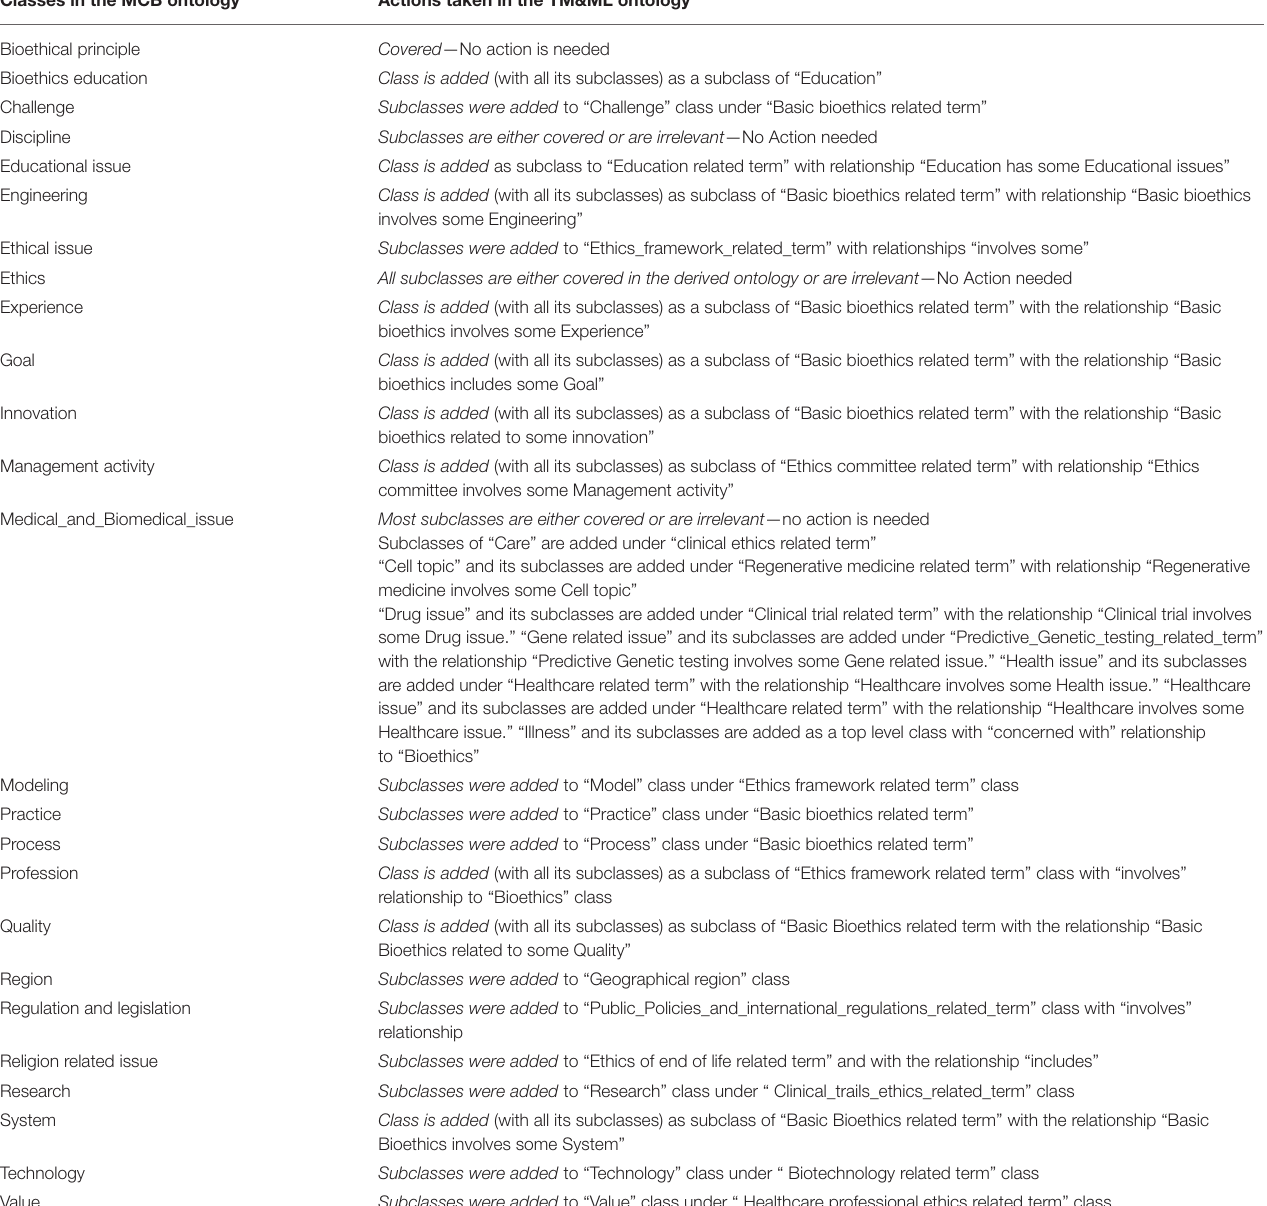
TABLE 1 | The detailed MCB ontology classes that contributed to interfacing to the TM&ML ontology resulting with the iOntoBioethics unified bioethics ontology. Classes in the MCB